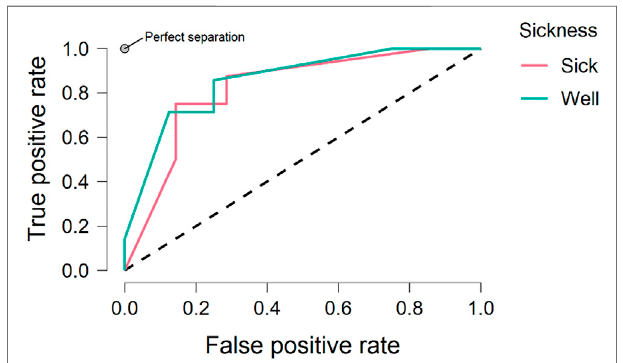
FIGURE 7 | Receiver operating curve (ROC) plots showing the performance of our vection-based model at all classi fi cation thresholds in terms of predicting Sick/Well group membership.